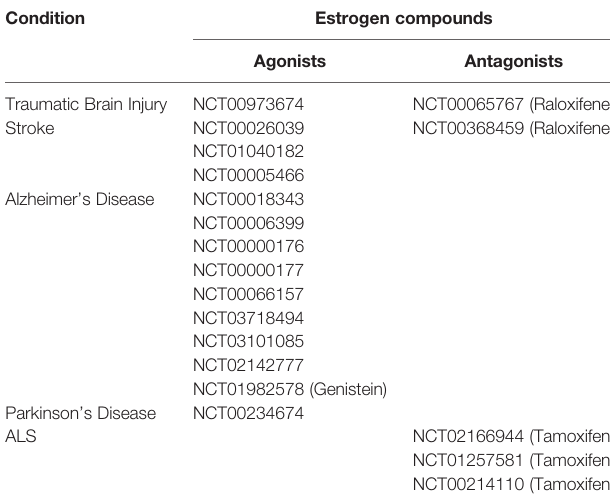
TABLE 2 | Clinical trials using estrogen agonists or antagonists in in fl ammatory CNS conditions. Condition Estrogen compounds